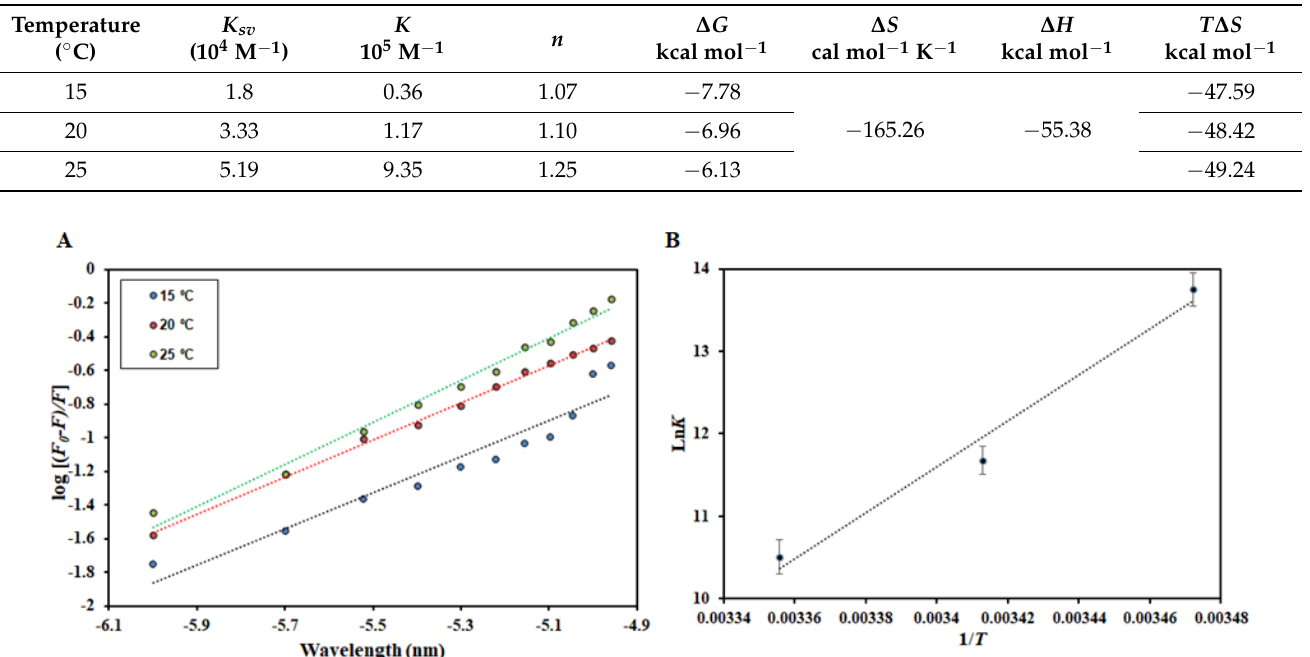
Figure 10. ( A ) Modified Stern–Volmer plot of the HSA–HpzA complex at different temperatures. ( B ) van ‘t Hoff plot of the HSA–HpzA complex.